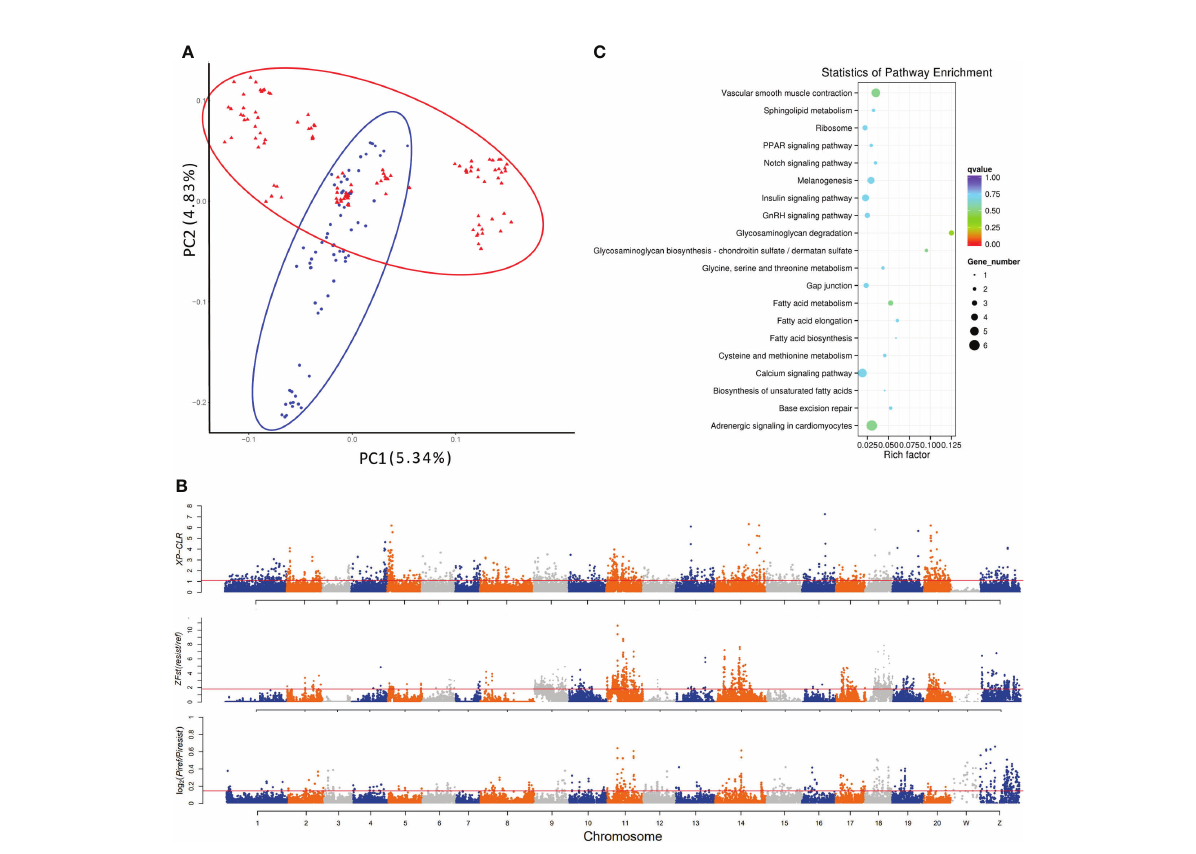
FIGURE 1 Genetic divergence and genome-wide identi fi cation of selective sweeps for vibriosis resistance in C. semilaevis . A total of 3,768,965 SNPs (MAF > 5%, missing rate < 10%) identi fi ed from 182 samples were used. (A) PCA shows a genetic divergence between pre-selected ( ref ) and post-selected ( resist ) individuals. The fi rst and second dimensional coordinates are plotted. Pre-selected and post-selected individuals are shown in blue and red colors, respectively. (B) Distributions of XP-CLR, Z ( F ST ) and qp (in log 2 ( qp ratio ( qp ref / qp resist )) values calculated using a 40 kb sliding window with a step size of 20 kb. The dashed horizontal lines correspond to the top 5% values of each measurement (where XP-CLR was 1.10, Z ( F ST ) was 1.82, and log 2 ( qp ratio) was 0.1455). (C) Top 20 enriched KEGG pathways for the 207 genes under selective sweep, which were simultaneously identi fi ed by XP-CLR, Z ( F ST ) and log 2 [ qp ratio ( qp ref/ qp resist